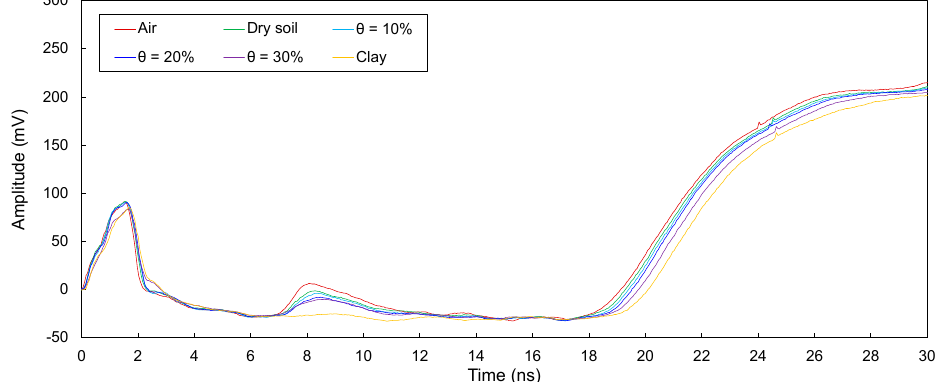
Figure 8. Measured signals for D1 with the defect filled with different materials of air; dry sand; wet sands with θ = 10%, 20%, and 30%; and clay. Sensors 2020 , 20 , x FOR PEER REVIEW 12 of 22